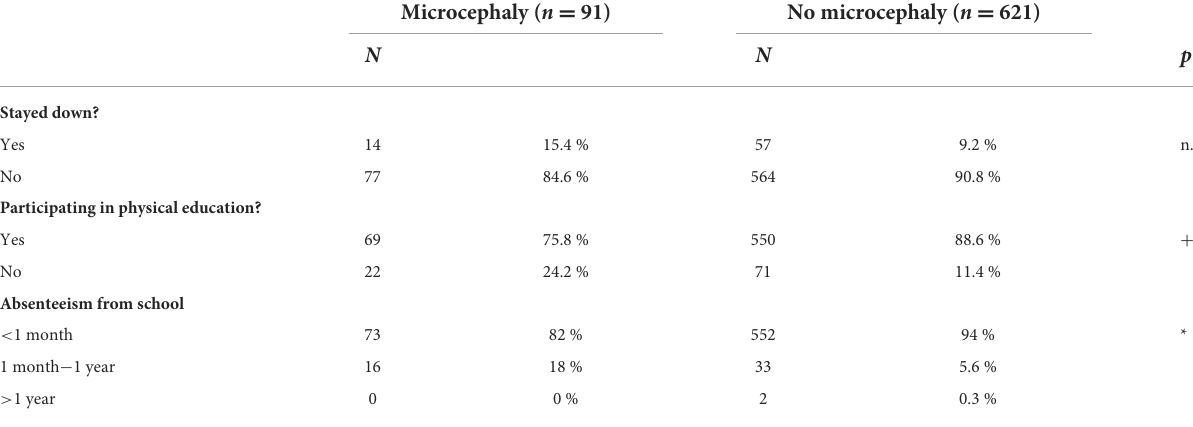
The table informs about school attendance in microcephalic and non-microcephalic patients. The whole cohort comprises 750, but data on the head circumference are missing in 28 patients. Thus, the sum of microcephalic and non- microcephalic patients is 712. * denotes significant difference compared to non-microcephalic p < 0.001, + denotes p < 0.05, n.s. = insignificantdataregardingmissedschooltimewasmissingin n =